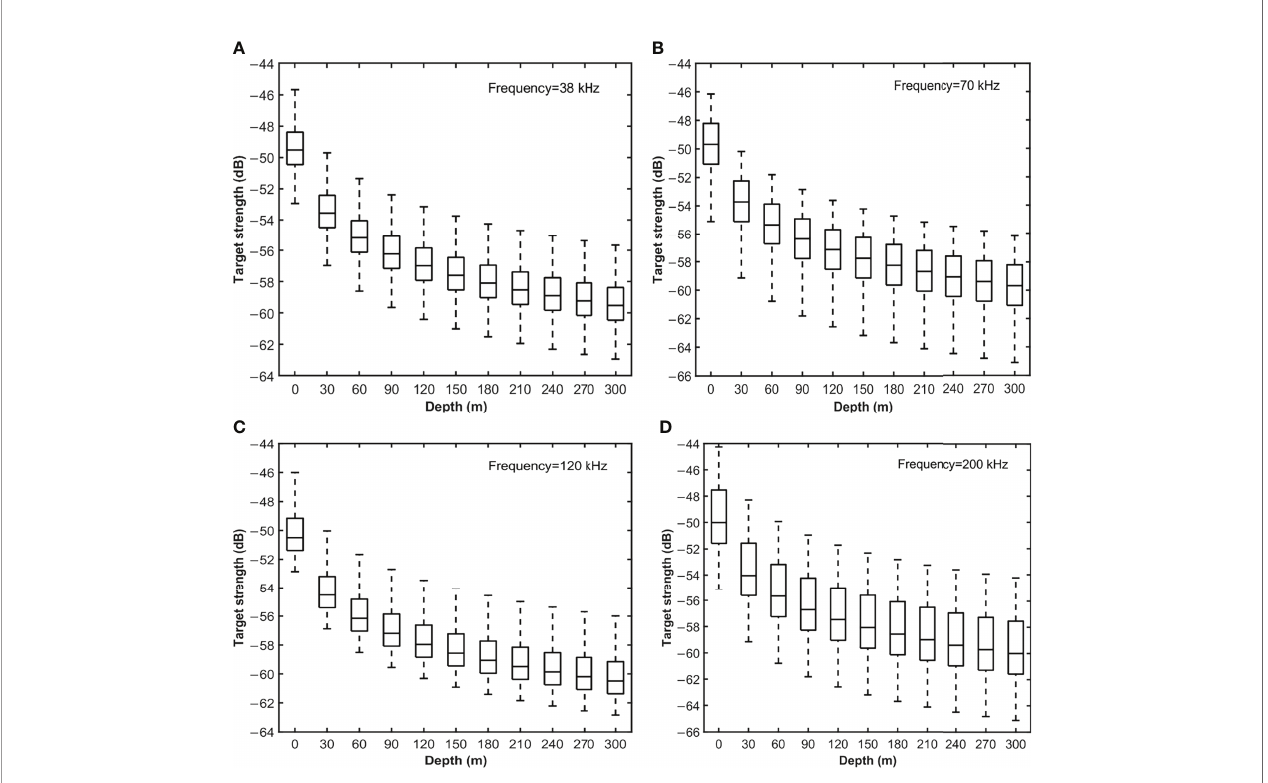
FIGURE 4 | TS variation relative to depth when the angle distribution is N [ − 3°,4°] at (A) 38 kHz, (B) 70 kHz, (C) 120 kHz and (D) 200 kHz. On each box, the central line indicates the median TS value of all samples. The bottom and top edges of the box indicate the 25th and 75th percentiles, respectively. The whiskers extend to the most extreme data without